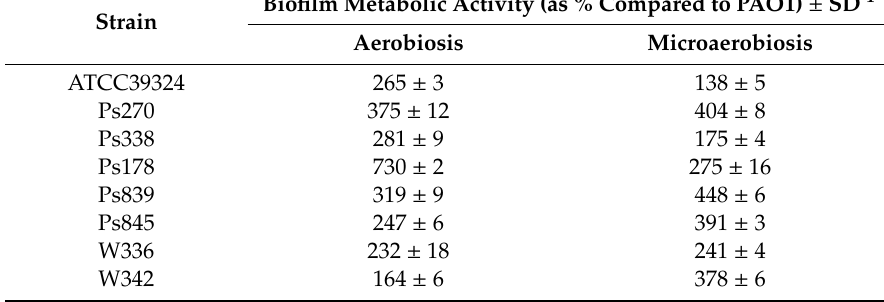
Table 4. Metabolic activity of bacteria within the biofilm formed during 72 h at 37 ◦ C in SCFM medium under aerobic and microaerobic conditions determined by fluorescein diacetate staining